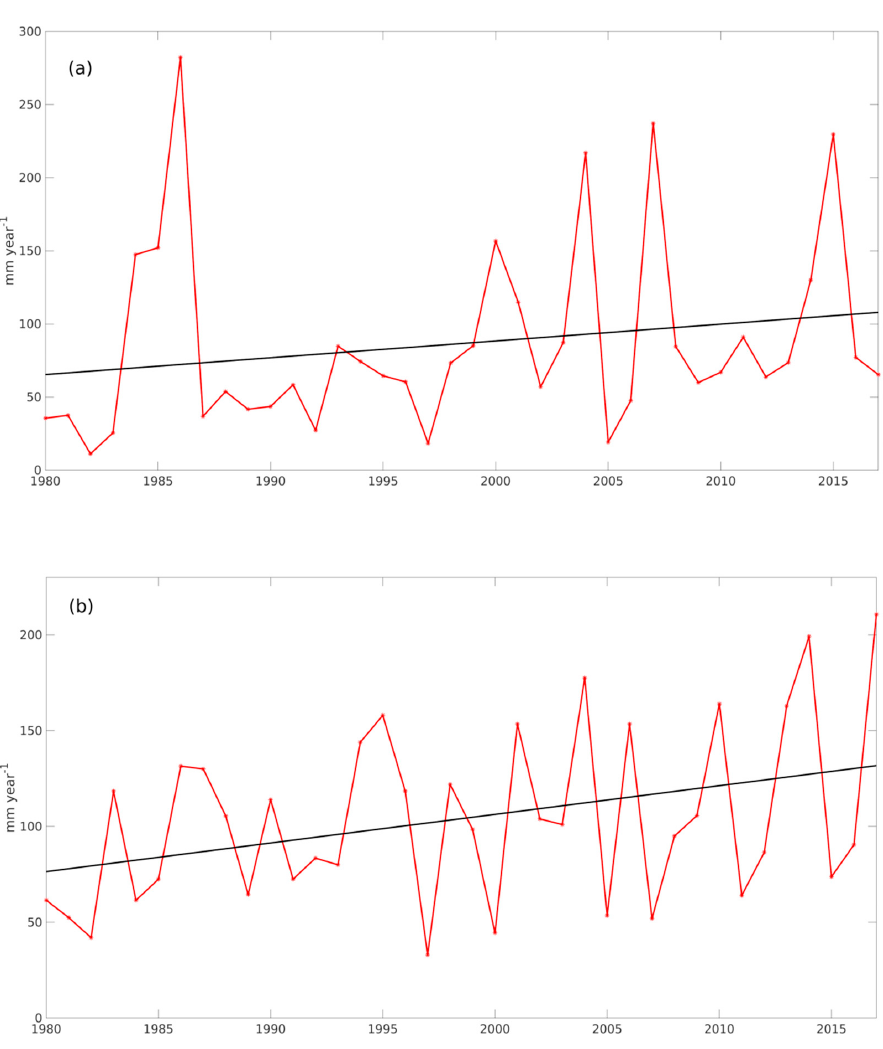
Figure 5. Examples of time series at Presa El Niagara ( p ≤ 0.05) ( a ) and La Tinaja ( p ≤ 0.05) ( b ) weather